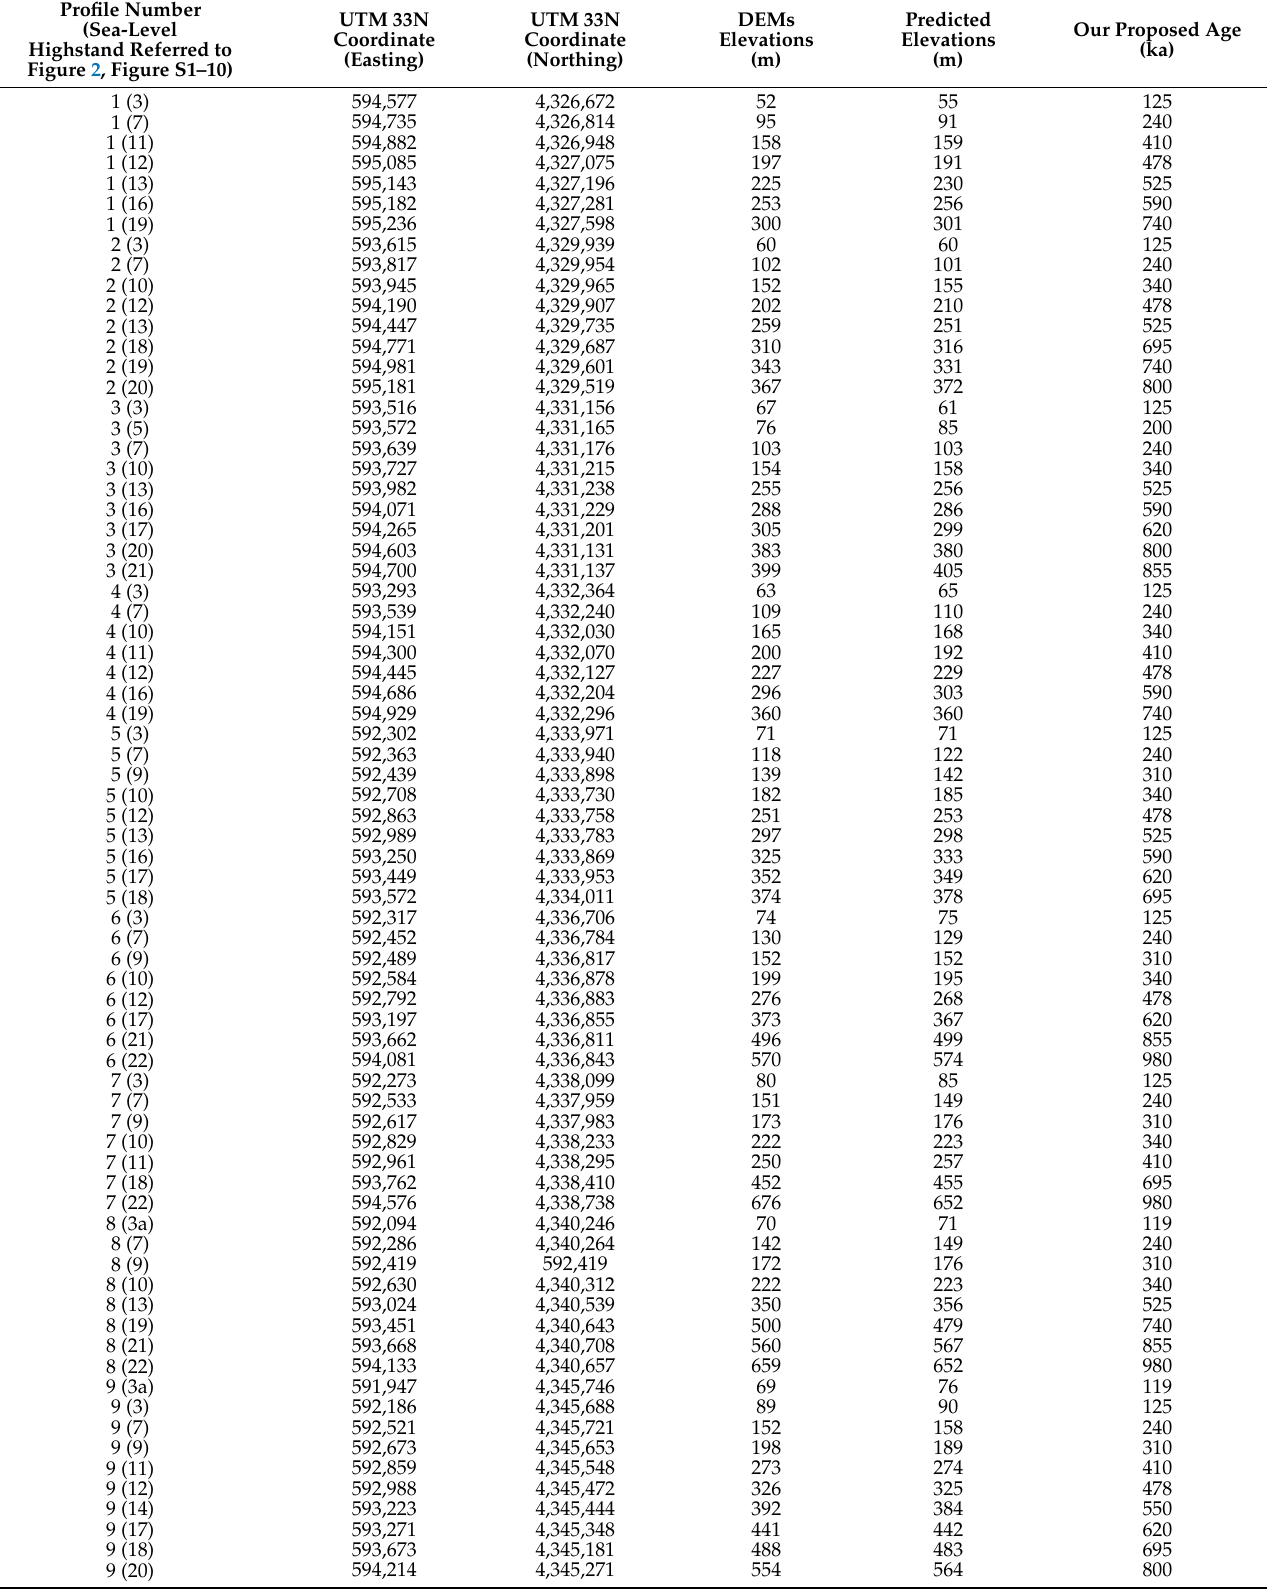
Table 4. Mapped inner edges from DEM analysis with refined ages for marine terraces assigned via synchronous